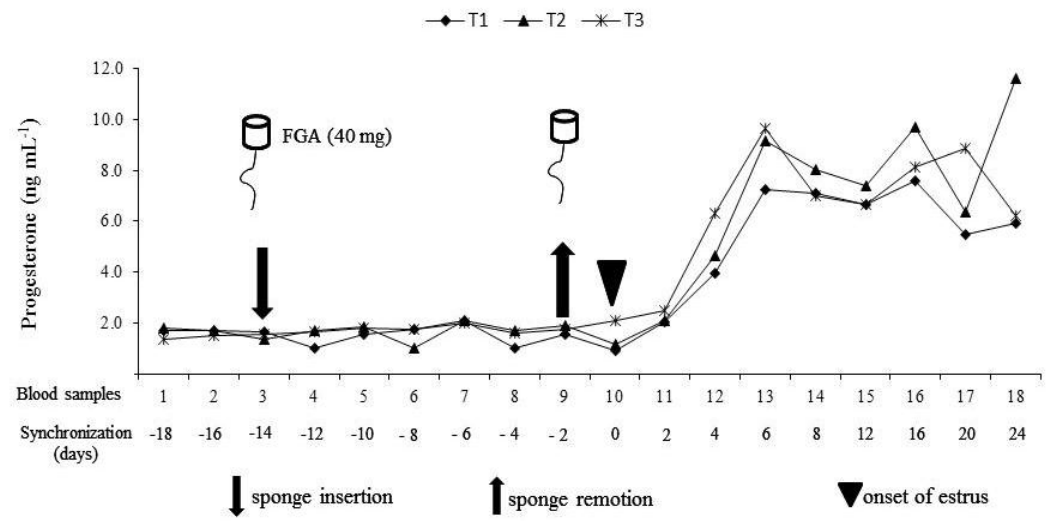
Figure 1. Progesterone concentration and synchronization protocol with intravaginal sponges. n: